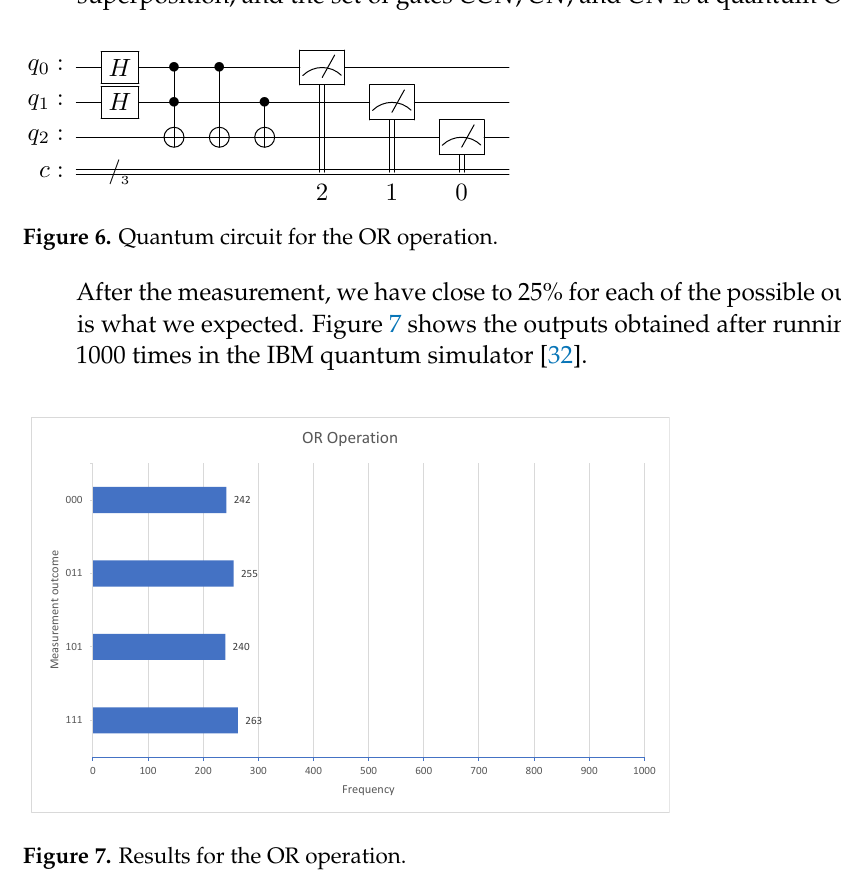
Figure 7. Results for the OR